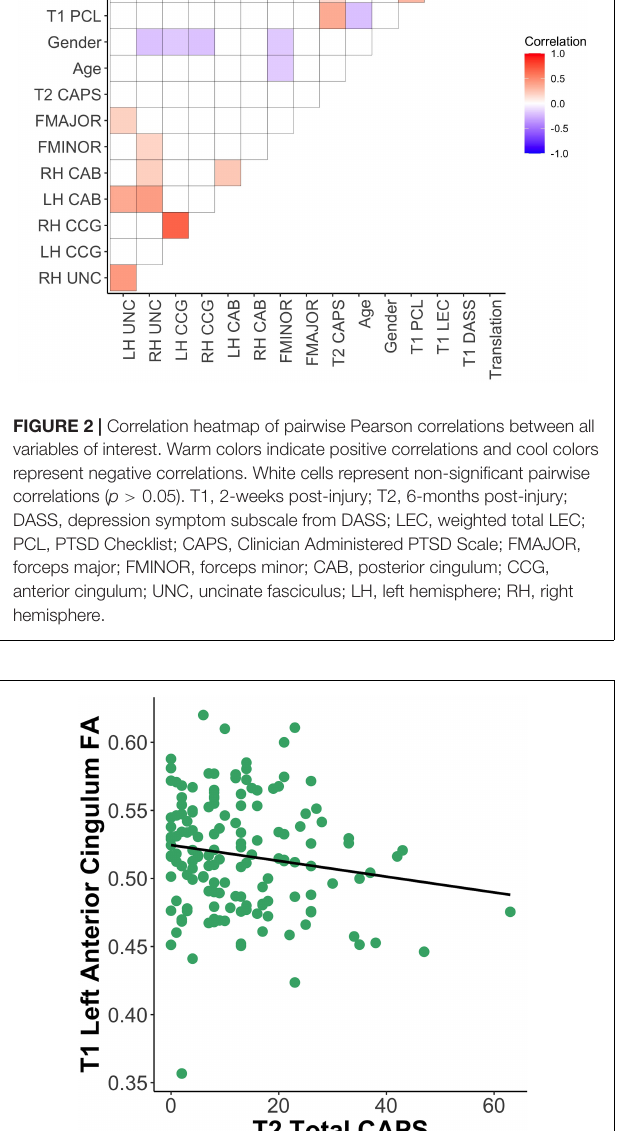
FA was related to greater total CAPS-5 symptoms